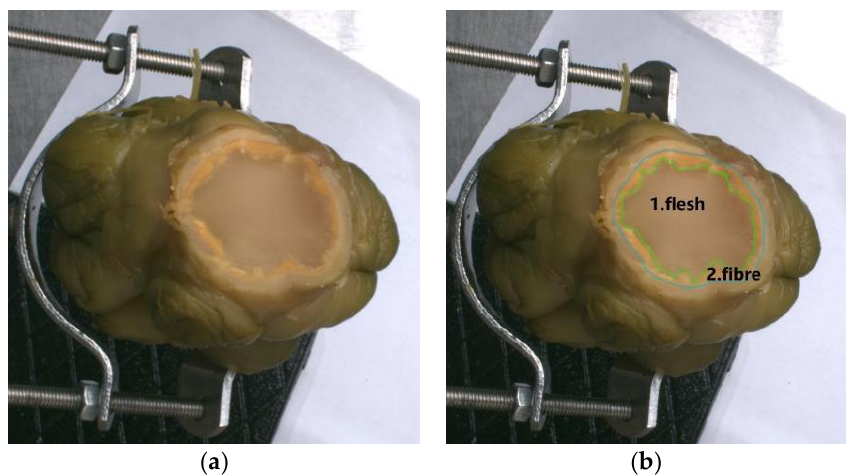
Figure 1. ( a ) Picture of a section of preserved Szechuan pickle; ( b )the region within the green line is flesh, and the region surrounded by the blue and green line is fibre.